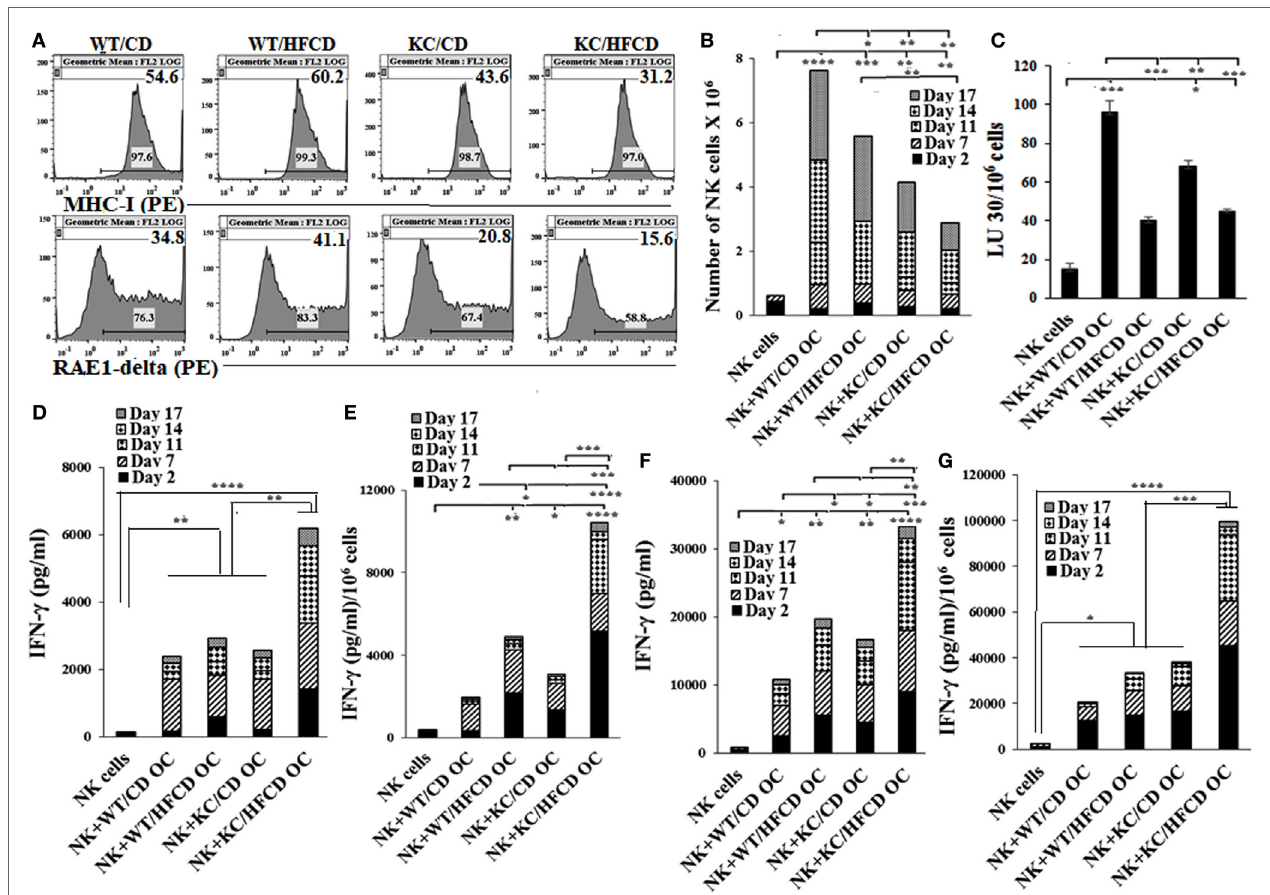
FigUre 2 | Allogeneic natural killer (NK) cells from WT mice fed with control diet (CD) expanded less and mediated less cytotoxicity, but demonstrated augmented IFN- γ secretion when cultured with osteoclasts from KC mice fed with high-fat calorie diet. WT and KC mice were fed with a CD or high-fat calorie diet as described in Section “Materials and Methods.” Bone marrow was harvested after animals were sacrificed and single cell suspension was prepared as described in Section “Materials and Methods.” Monocytes were purified from the BM cells and were used to generate OCs as described in Section “Materials and Methods.” Flow cytometric analysis was used to determine expression of RAE1-delta and MHC-class I on day 21 mature OCs (a) . NK cells purified from splenocytes of WT mice fed with CD were activated with IL-2 (10,000 U/ml) and LPS (100 ng/ml), and cultured in the presence/absence of OCs from different mouse groups at NK:OCs; 1:0.5 ratio, and the number of expanded NK cells were determined on the days shown in the (B) . NK cells expanded by the OCs as described in (B) were used as effector cells in a standard 4-h 51 Chromium release assay. The LUs 30/106 cells were determined as described in Figure 1B (c) . NK cells were purified from WT splenocytes and cultured with OCs as described in (B,D,e) or treated with IL-2 in the presence of sonicated AJ2 (sAJ2) and cultured with OCs at the ratio of (0.5:1:2; OCs:NK:sAJ2) (F,g) and the supernatants were harvested on the days shown in the figures and secretion of IFN- γ were determined. One of three representative experiments is shown in Figure 2